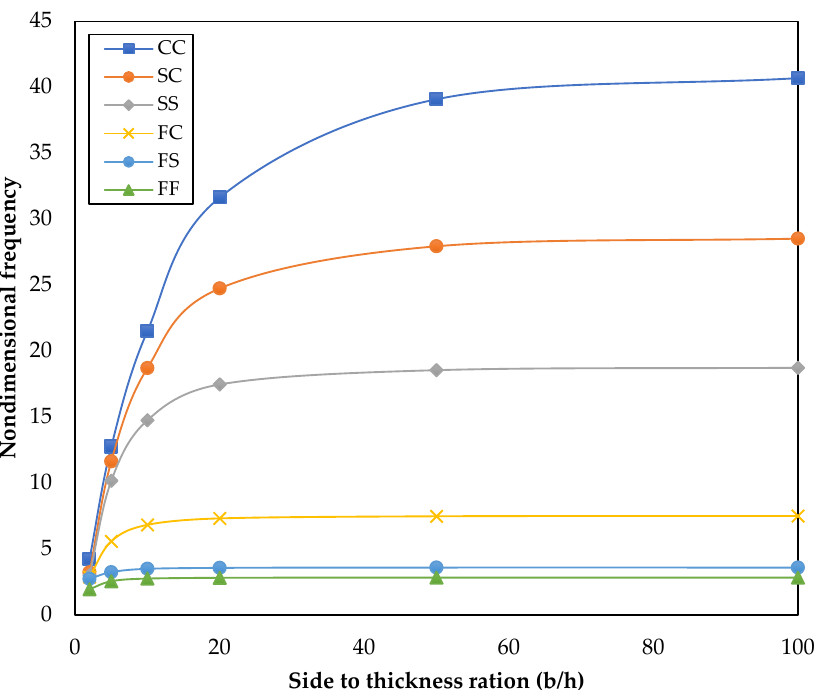
Figure 7. Effect on the non-dimensional frequency of the square orthotropic plate for the Levy-type boundary condition with a side-thickness ratio ( b / h ) and the given value of Young’s modulus ratio (cid:16) (cid:17) E 1 = 40 . E 2